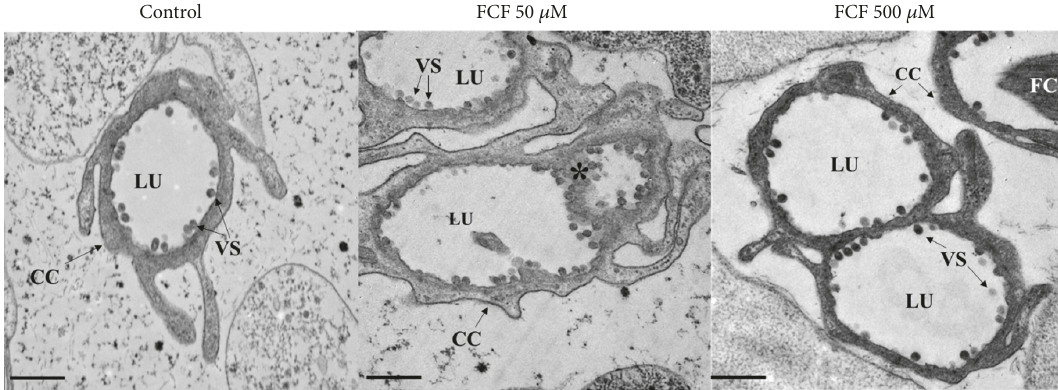
Figure 4: Effect of FCF on the morphology of protonephridial ducts visualized by transmission electron microscopy. CC, cellular channel; LU, lumen; M, mitochondria; VS, vesicles. Regions presenting structural changes are indicated by an asterisk. Scale bar, 500